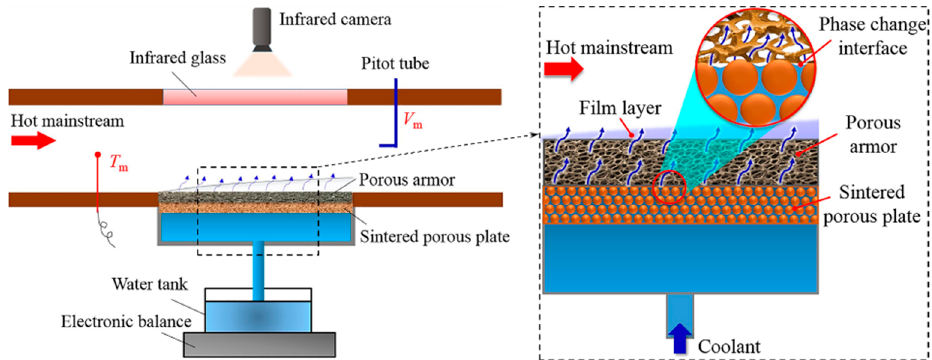
Figure 31. Schematic diagram of the self-pumping transpiration cooling system. Adapted with permission from [125]. Copyright 2019 Elsevier.